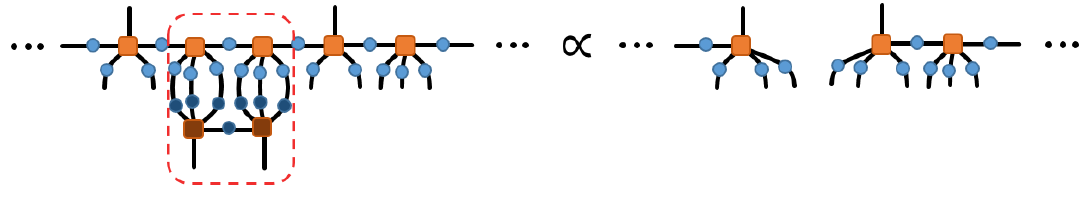
(cid:16) (cid:1) (cid:1) (cid:1) 1 0 0 1 0 (cid:1) (cid:1) (cid:1) (cid:17) becomes disconnected when contracting (cid:1) (cid:1) (cid:1) 2 3 3 2 3 (cid:1) (cid:1) (cid:1) h 1 1 i nh 1 i h 1 1 io in S c = ; 3 3 4 3 3